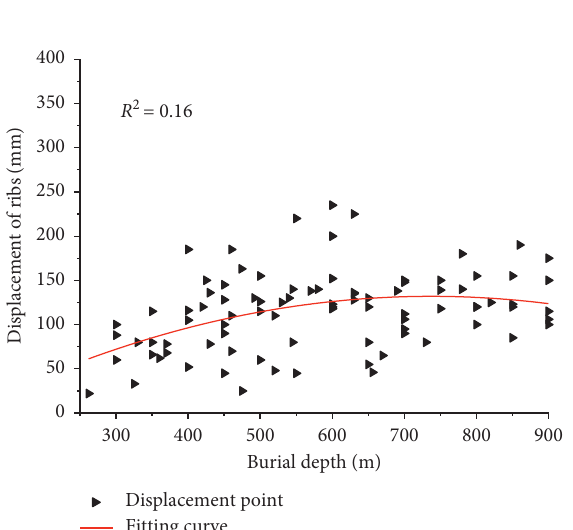
Figure 11: Displacement of ribs (25 th day).